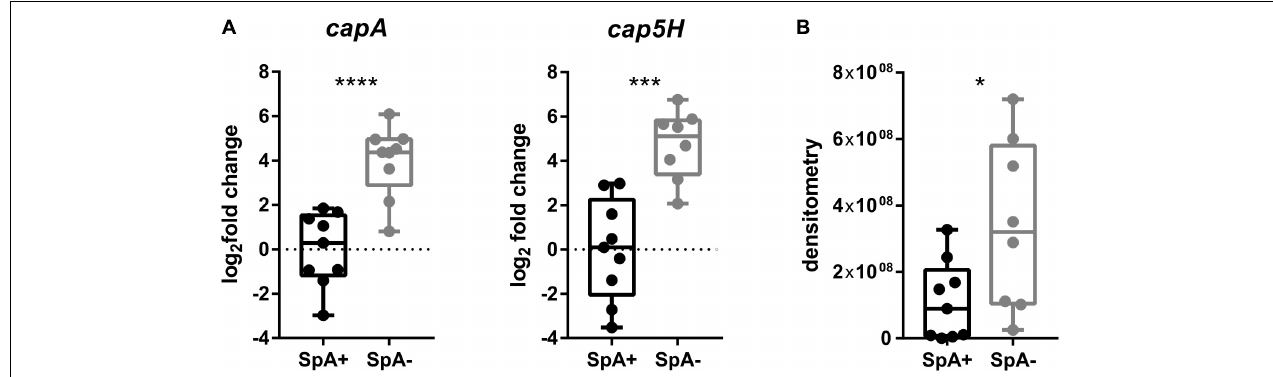
FIGURE 6 | Capsule biosynthesis operon transcription and capsule production in SpA + and SpA - strains. (A) capA and cap5H transcript levels in SpA + and SpA - strains. (B) Capsule production in SpA + and SpA - strains. Bars indicate the medians, whiskers the maximum and minimum values. All values are relative to the mean of SpA + strain levels. Statistical significance is calculated with Welch’s t -test, ∗ p < 0.05, ∗∗∗ p < 0.001, ∗∗∗∗ p < 0.0001.